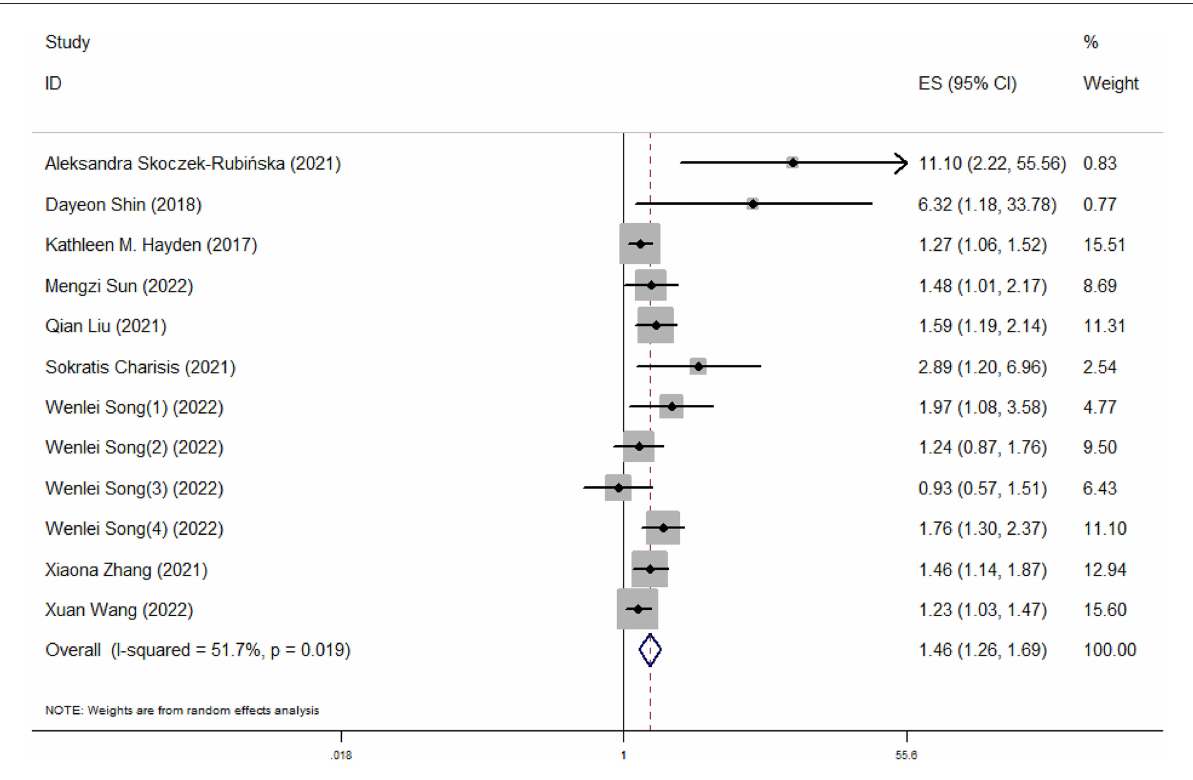
FIGURE2 Meta-analysis results of higher DII for the risk of cognitive